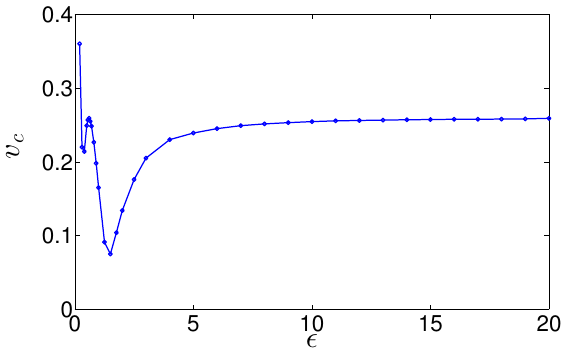
Figure 7 . The critical velocity v c as a function of ǫ . The numerical simulations show that ǫ is a cutoff for the monotonic behavior of this function. For any ǫ greater than this cutoff value of 1 . 5, we see that v c increases monotonically with ǫ . However, this is not the case for ǫ less than the cutoff